Question: Does the figure show an increasing or a decreasing trend?
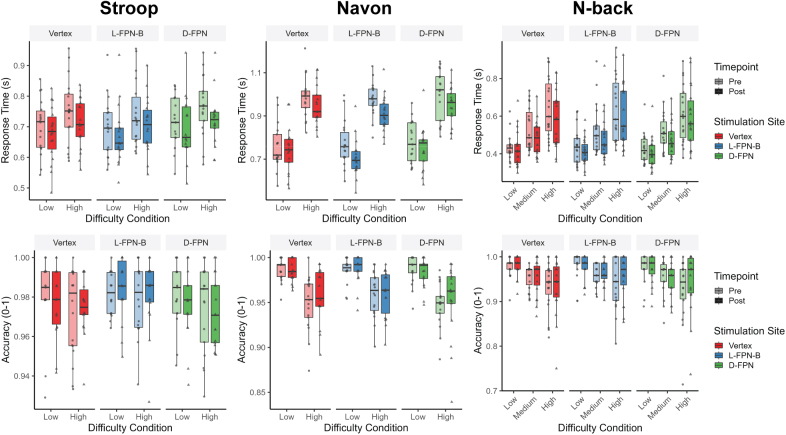
Answer: increasing